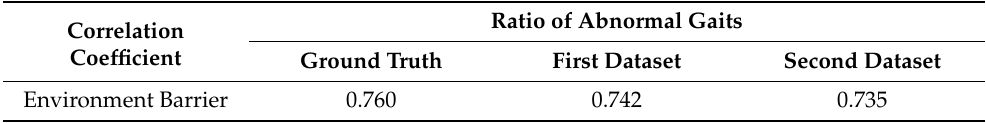
Table 2. Correlation between environment barriers and three types of ratio of abnormal